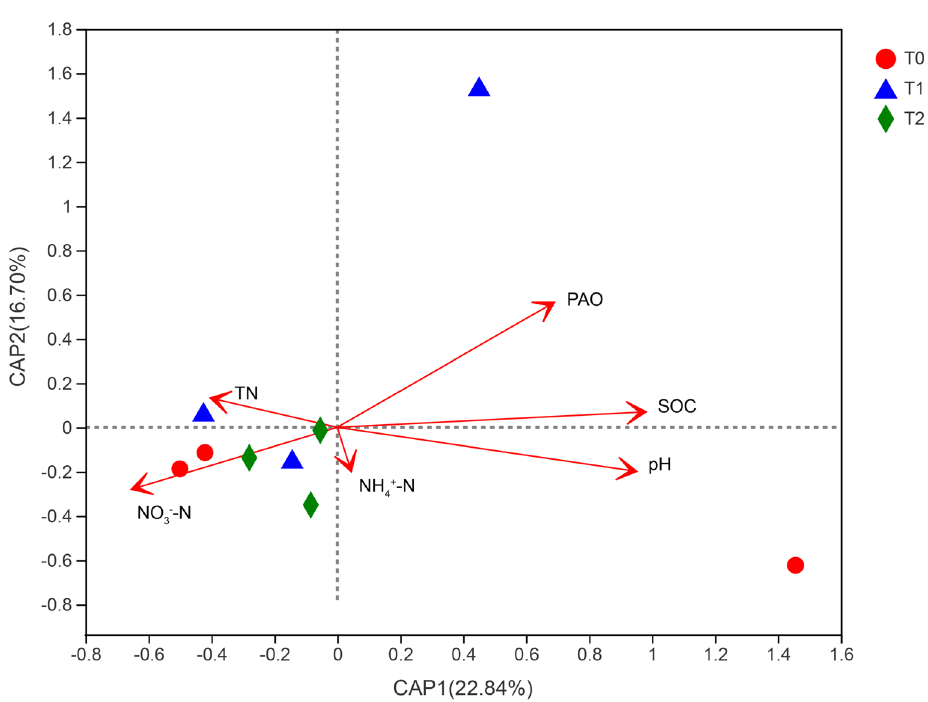
Figure 7. Distance-based redundancy analysis (db-RDA) of ammonia-oxidizing archaea (AOA) communities according to edaphic factors. Notes : T 0 = Traditional irrigation; T 1 = Traditional irrigation and fertilization practice; T 2 = Water—saving irrigation and optimizing fertilization. SOC: soil organic carbon; N: nitrogen; TN: total N;